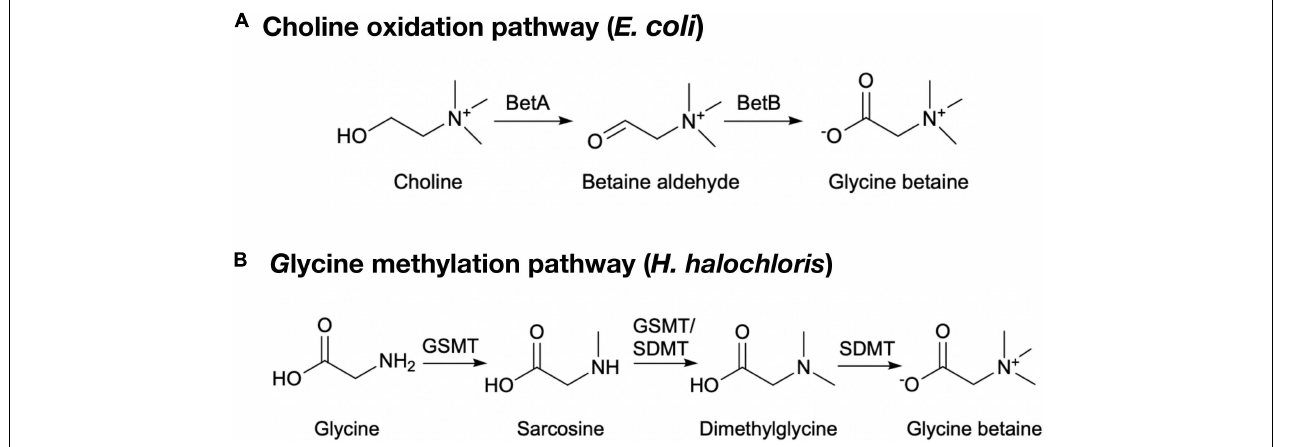
FIGURE 1 | Glycine betaine biosynthetic pathways in microorganisms. (A) The choline oxidation pathway in E. coli . BetA, choline dehydrogenase; BetB, betaine-aldehyde dehydrogenase. (B) The glycine methylation pathway in H. halochloris. GSMT, glycine sarcosine N -methyltransferase; SDMT, sarcosine dimethylglycine N